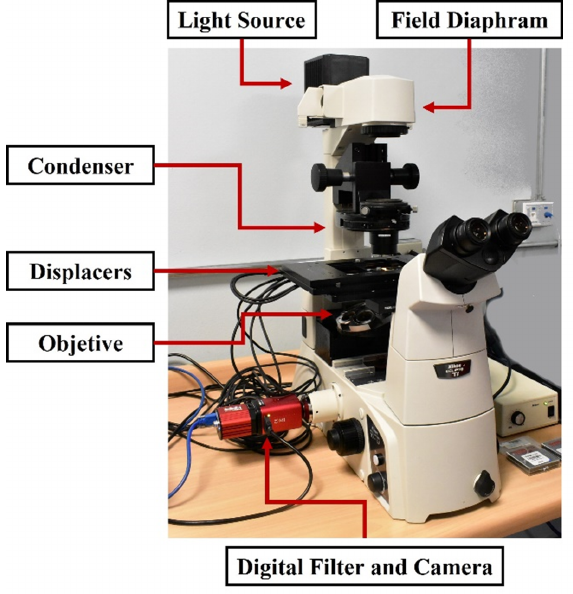
Figure 3. Hyperspectral microscope system. The setup also includes a high-speed motorized XY scanning stage (MLS203 Base, Thorlabs) with a DC motor controller (BBD302, Thorlabs) for sample positioning. The whole control and measurement system is programmed in Labview as a graphical user